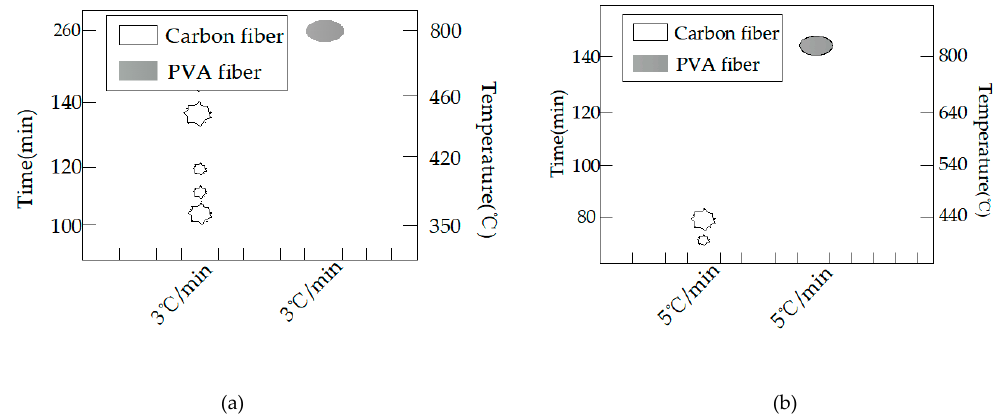
Figure 15. The burst statistics of concrete with different heating rates: ( a ) A heat rate of 3 °C/min and